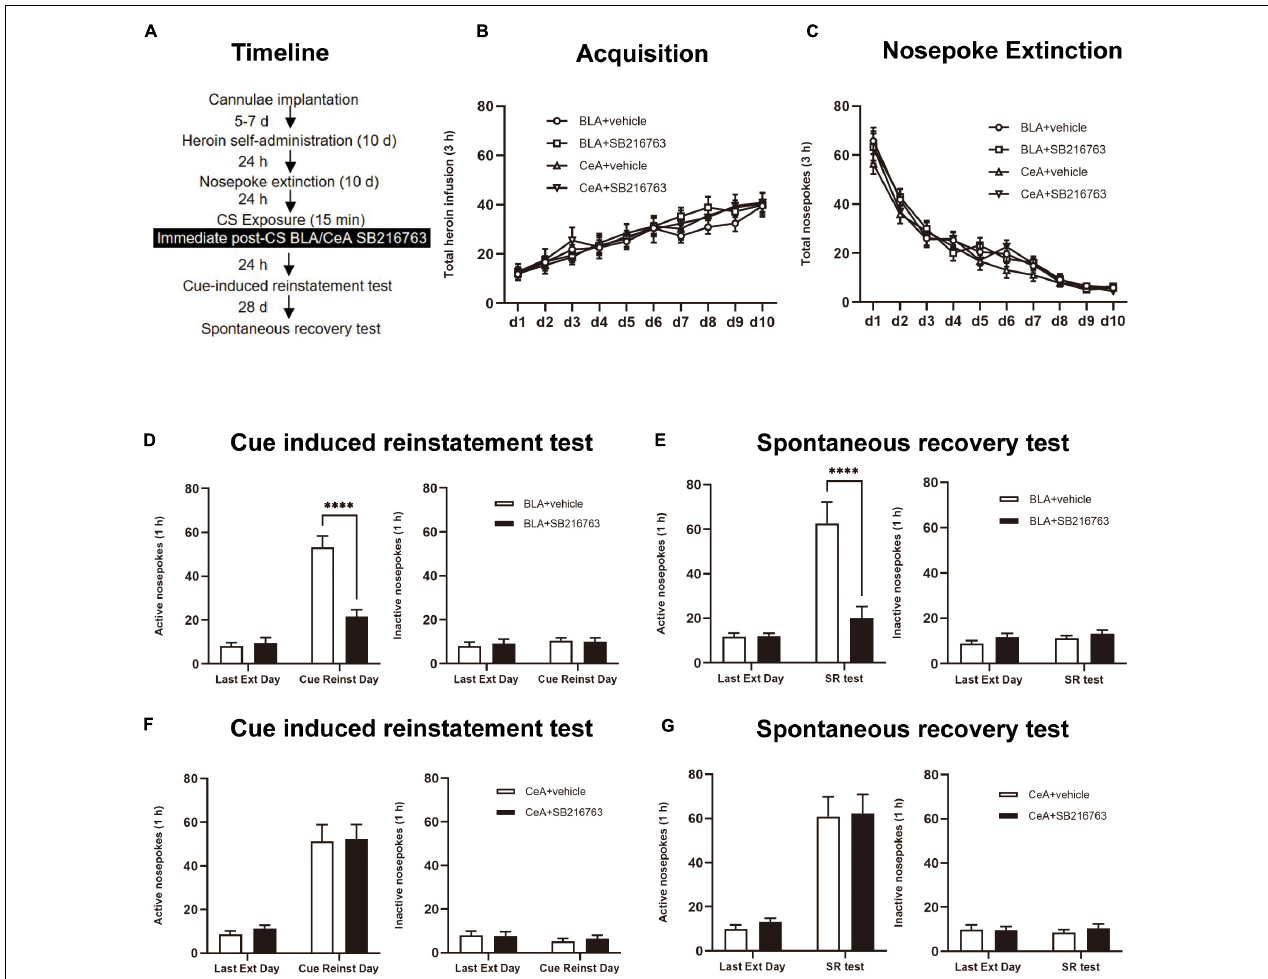
FIGURE 3 | Immediate post-CS SB216763 treatment in BLA rather than CeA can reduce subsequent cue-induced heroin seeking and the spontaneous recovery of heroin seeking. (A) Timeline of heroin self-administration, nosepoke extinction, cue-induced reinstatement test and spontaneous recovery test. (B) Total number of heroin infusions during acquisition of heroin self-administration. (C) Total number of active nosepoke responses during extinction training sessions. (D,F) Active (left) and inactive (right) nosepoke responses during the last extinction training session and the cue-induced reinstatement test. (D) Nosepoke responses of rats with BLA drug injection. (F) Nosepoke responses of rats with CeA drug injection. (E,G) Active (left) and inactive (right) nosepoke responses across the last extinction training session and spontaneous recovery test. (E) Nosepoke responses of rats with BLA drug injection. (G) Nosepoke responses of rats with CeA drug injection. n = 10 mice per group. Data are means ± SEM, ∗∗∗∗ p < 0.0001, compared with the vehicle group. CS, conditioned stimulus; Ext, extinction; Reinst, reinstatement; SR, spontaneous